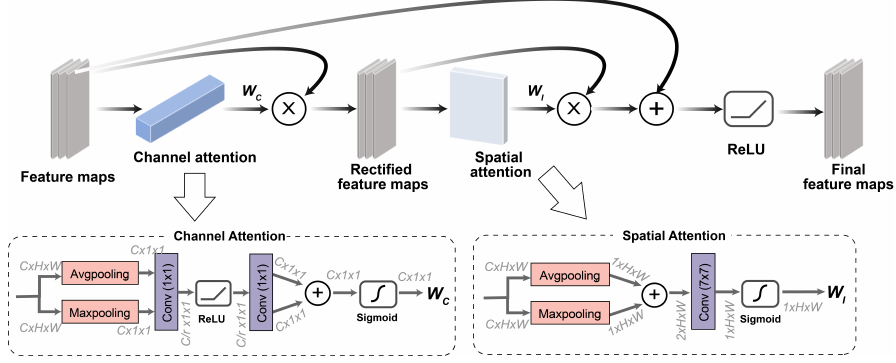
Figure 2. Schematic of the attention block. It contains two sequentially sub-modules: channel attention module and spatial attention